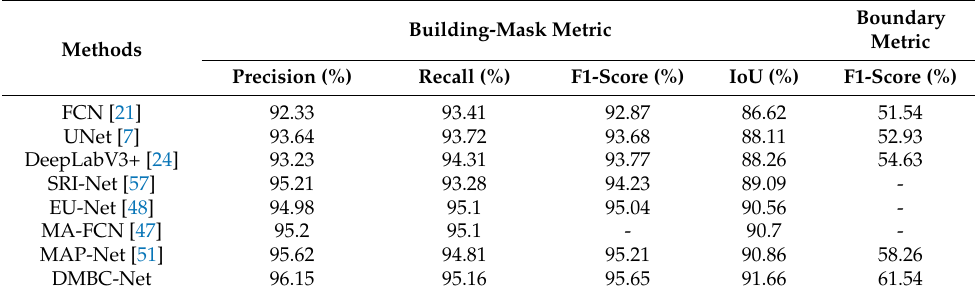
Table 1. Quantitative comparison with state-of-the-art methods on the WHU aerial data set.